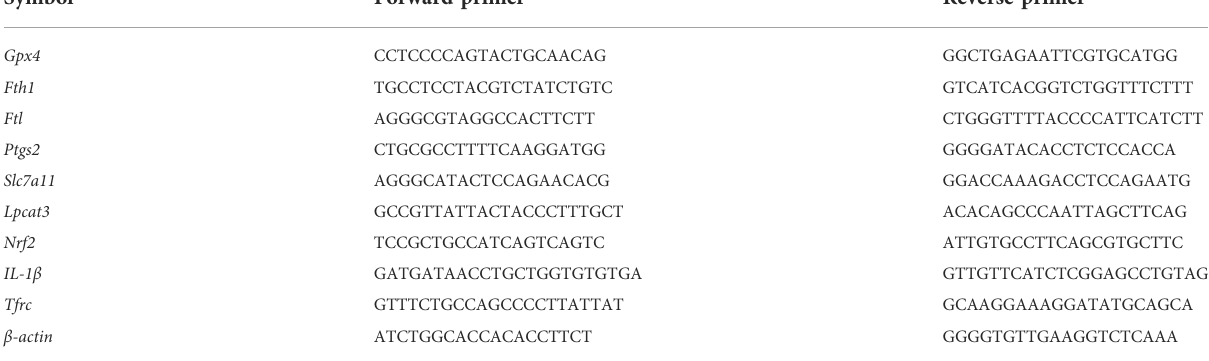
TABLE 1 The speci fi c primer